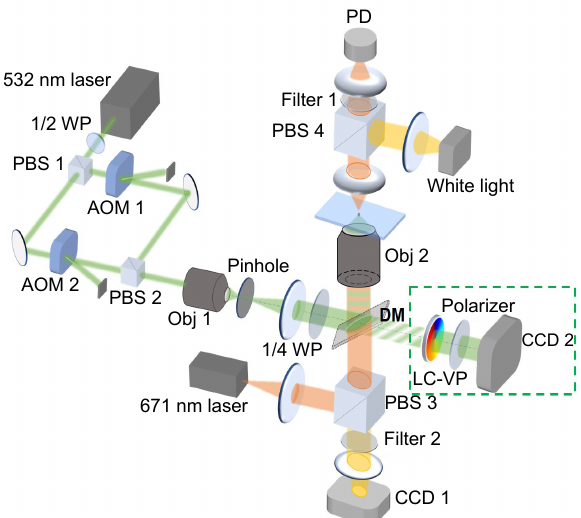
Fig. 2 | Schematic diagram of the experiment. The trapping beam is produced by a 532 nm laser and a Mach-Zehnder interferometer based on heterodyne interference. Devices in the green dashed box: a polarization detector made of a liquid crystal vortex half wave-plate and a polarizer which determines the polarization angle of the output trapping field. WP: wave plate; DM: 561 nm long pass dichroic mirror mounted on a flippable frame; PD: photodiode; PBS 1-4: polarized beam splitter; LC-VP: Liquid crystal based vortex half-wave plate; Obj 1: 10x objective; Obj 2: 100x objective with NA of 1.4; Filter 1-2: 635 nm long-pass